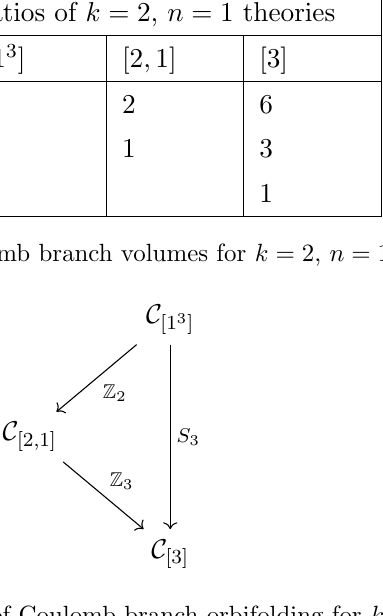
Figure 10 . Commutative diagram of Coulomb branch orbifolding for k = 2, n = 1 theories.